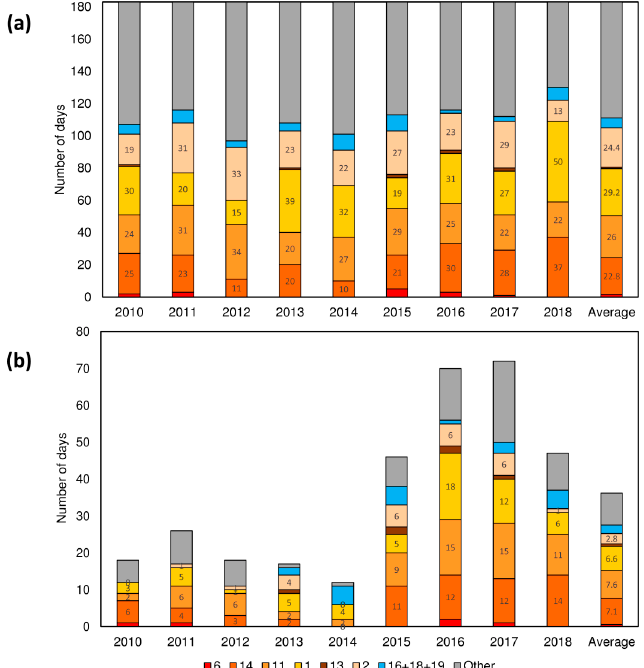
Figure 7. Chronogram (2010–2018) of the annual number of days with restrictions of ( a ) landing operations and ( b ) take-off operations lasting for more than 1 h (lines, left axis) or 6 h (bars, right axis) during summertime (red) and wintertime (blue) periods at the RWY05 site at the Madeira Airport. The average number of the WTs and the temporal evolution of the number of days of the WTs is shown in Figure 8 for summertime. To improve the clarity of the figure only the WTs responsible